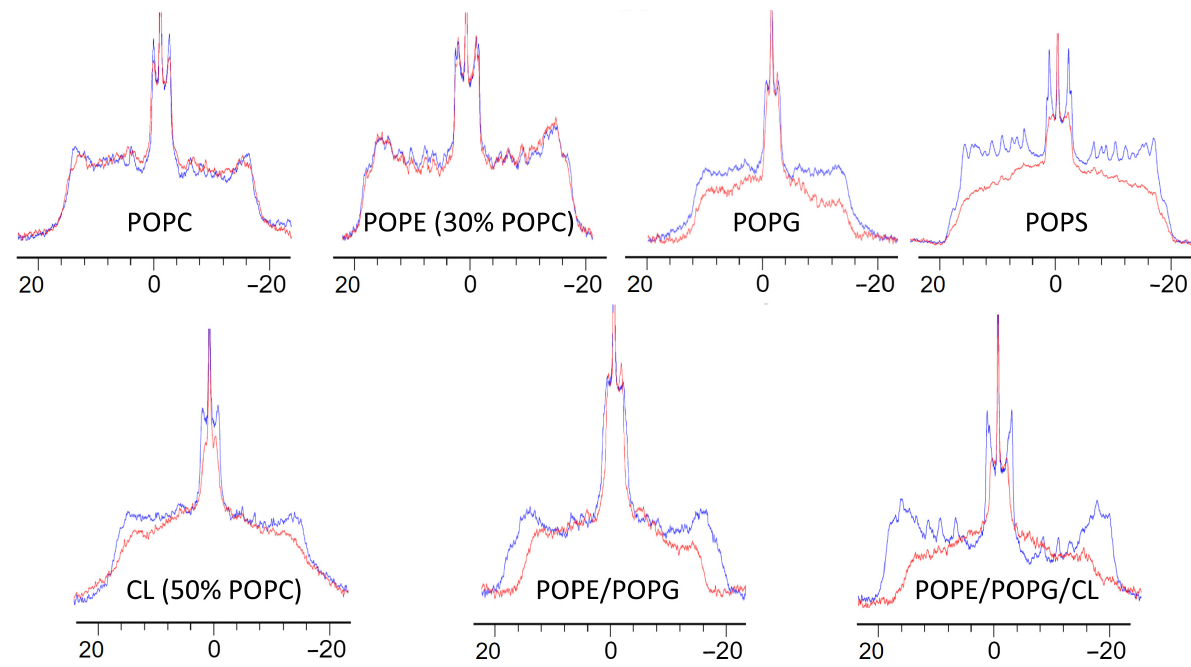
Figure 3. Static 2 H NMR spectra of various multilamellar vesicles (MLVs) in the absence (blue) and in the presence (red) of K11 peptide.